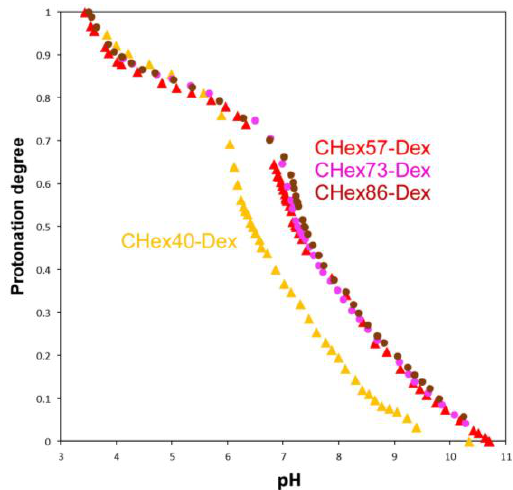
Figure 3. Titration curves of dextran derivatives measured by acid-base titration using a conductivity meter. Table 3. pKa and protonation degree at pH 7.4 of dextran derivatives.